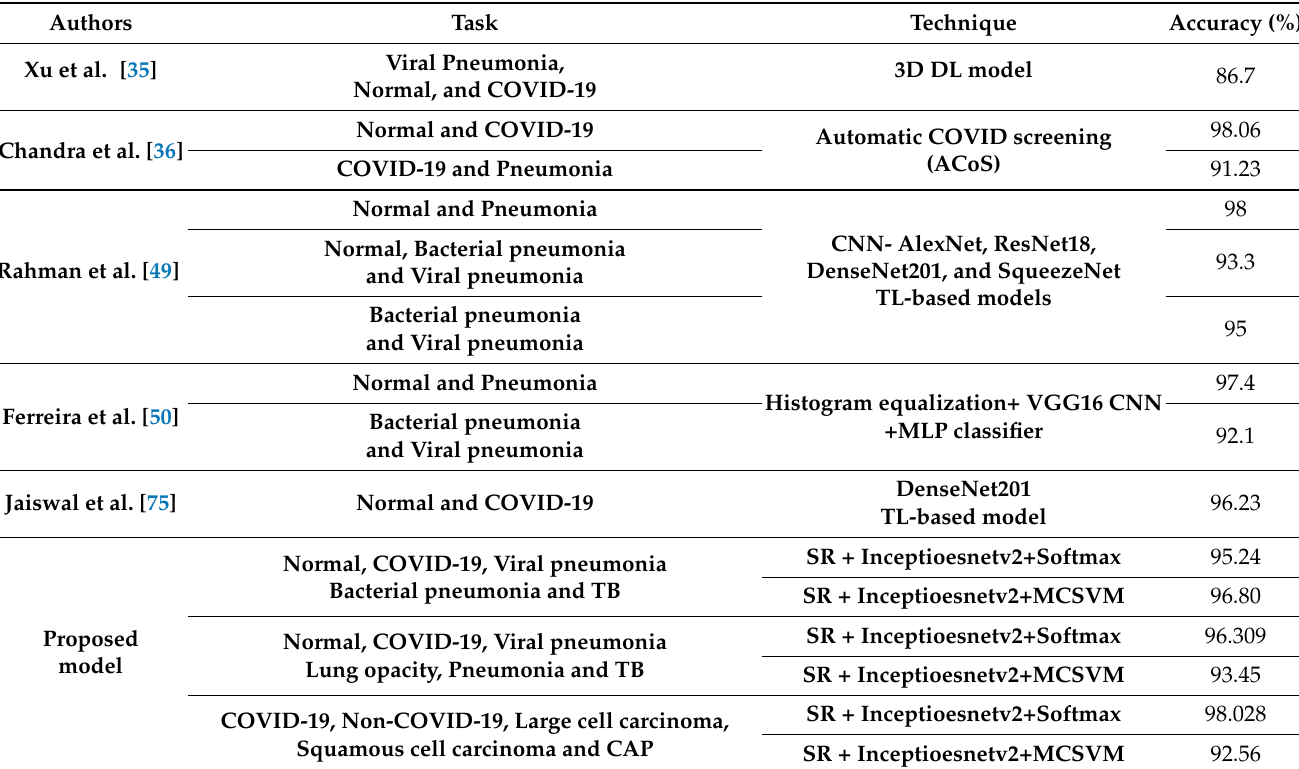
Table 13. Comparison with the state-of-the-art